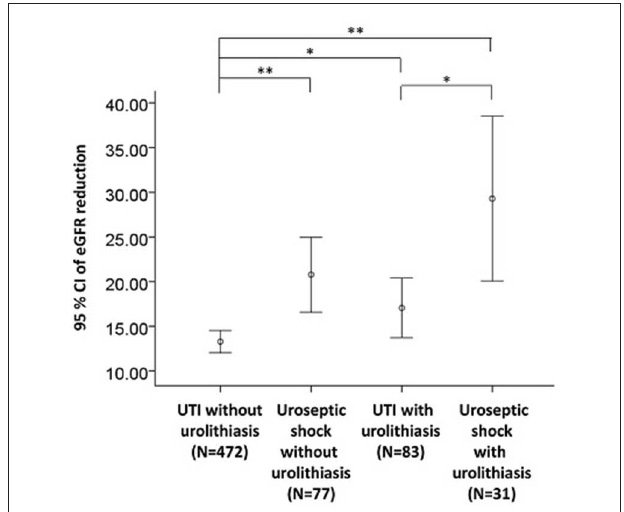
FIGURE 1 | eGFR reduction in UTI patients with respect to uroseptic shock and urolithiasis. eGFR, estimated glomerular filtration rate; UTI, urinary tract infection; eGFR reduction, baseline minus worst value of eGFR. * p < 0.05, ** p <